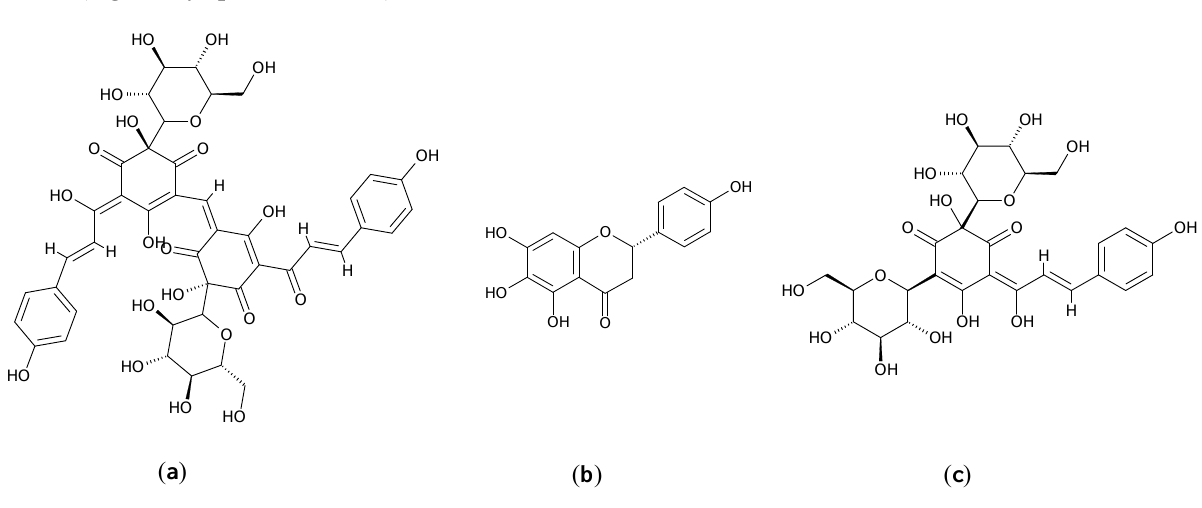
Figure 3. Bioactive phytochemicals of Carthamus tinctorius L.: ( a ) carthamin (a glucosylquinochalcone); ( b ) carthamidin (a flavonoid arising from chalcone); ( c ) safflomin A (a